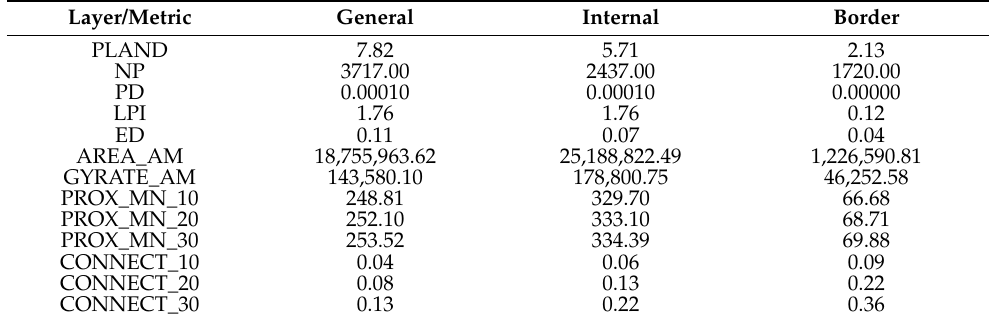
Table A2. Analysis of all metrics for layers that do not account country borders, specifically general, internal zone and border zone layers.